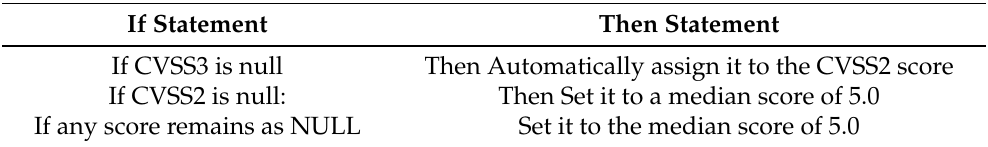
Table 2. Breakdown of Case Options and Coalesce in Listing 3, lines